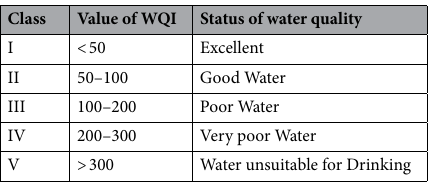
Table 3. Classification of water quality based on WQI value.